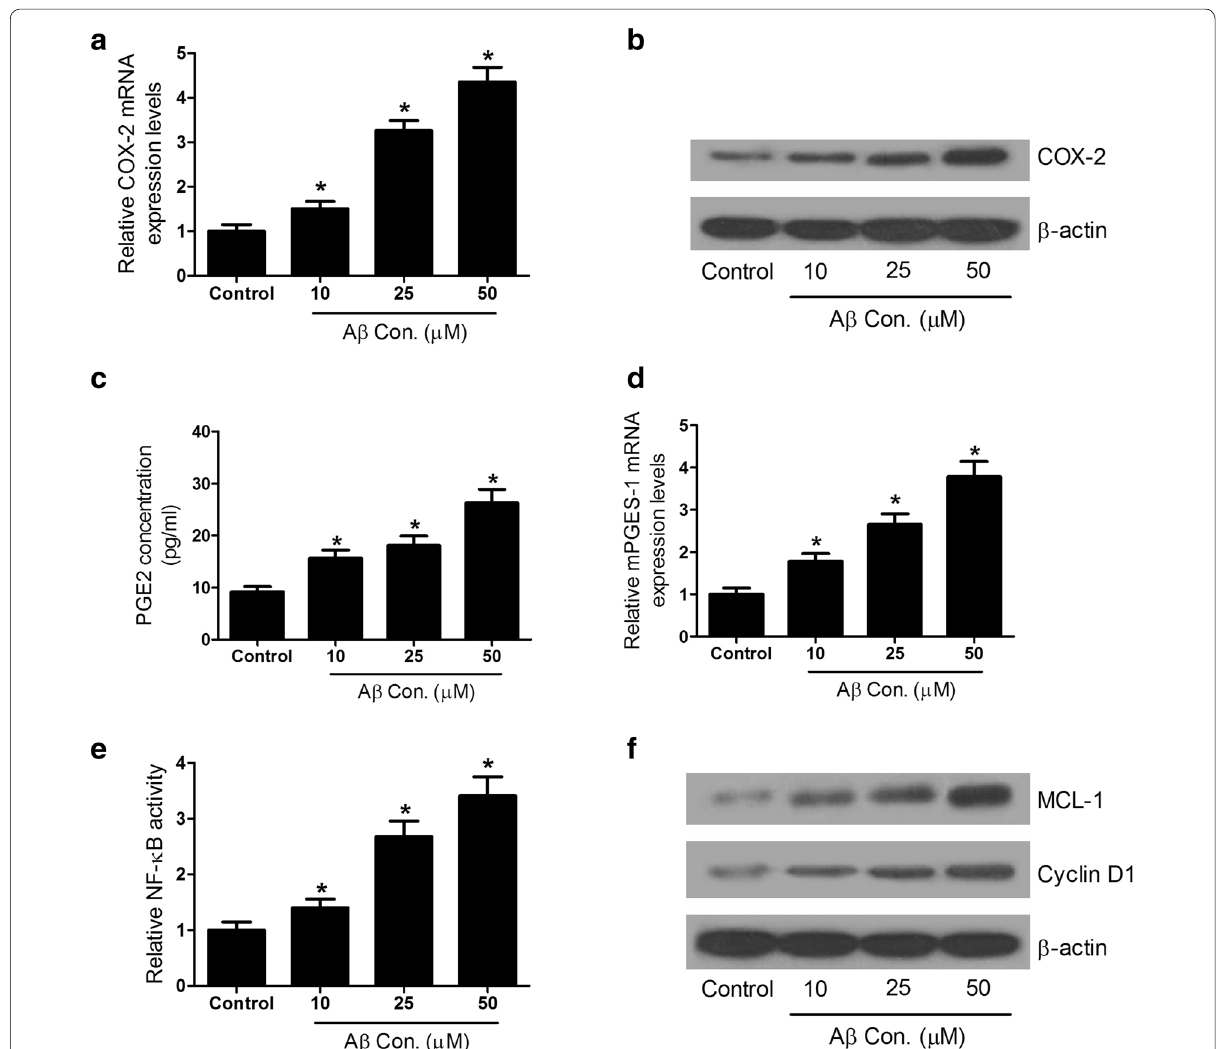
Fig. 3 Aβ treatment promoted COX-2 expression and PGE2 secretion, and activated NF-κB pathway in SH-SY5Y cells. SH-SY5Y cells was exposed to different concentrations (0, 10, 25, 50 μM) of Aβ for 48 h. a qRT-PCR analysis of COX-2 mRNA expression. b Western blot analysis of COX-2